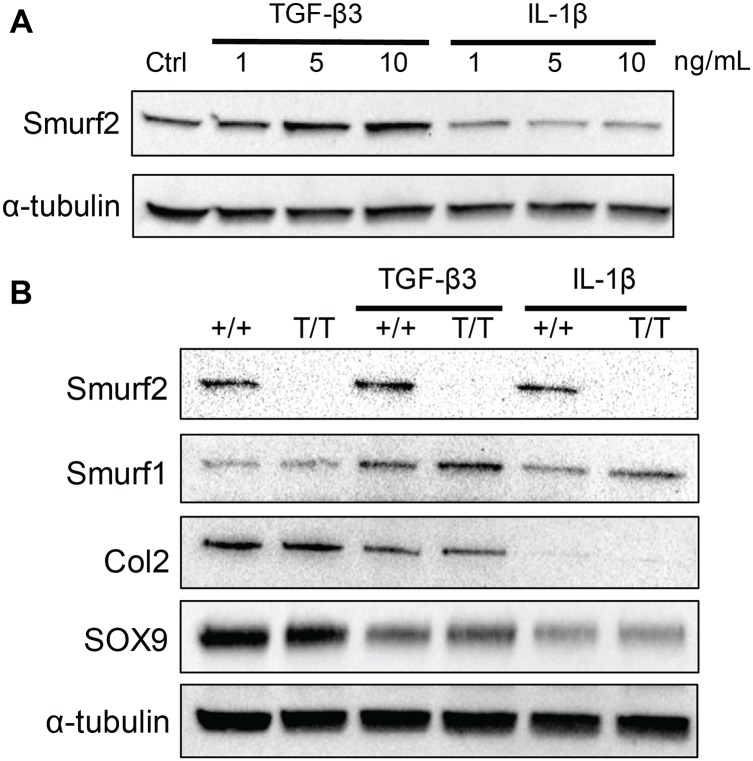
Smurfs protein expression changes upon 24-h treatment of TGF-β3 and IL-1β.A) WT chondrocytes show dose-dependent increase of Smurf2 protein with 24-h TGF-β3 treatment and dose-dependent decrease with 24-h IL-1β treatment. B) No compensatory increase of Smurf1 protein levels was detected between WT (+/+) and Smurf2-deficient MT chondrocytes (T/T) with and without treatment of TGF-β3 (10 ng/mL) or IL-1β (0.1 ng/mL). Type 2 collagen levels were also similar between WT and MT chondrocytes across all conditions.